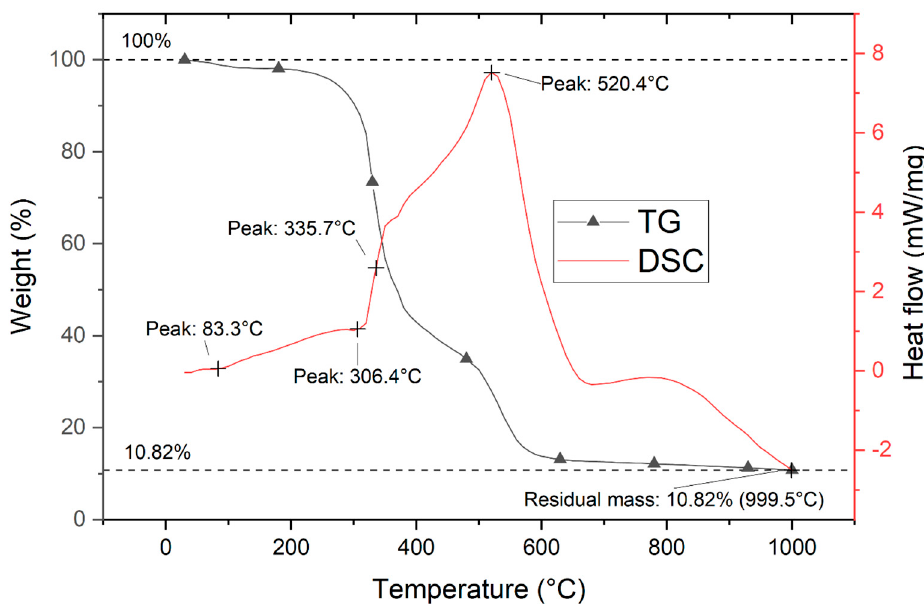
Figure 9. TGA and DTA curves for the composite containing 30 wt.% wheat straw powder.